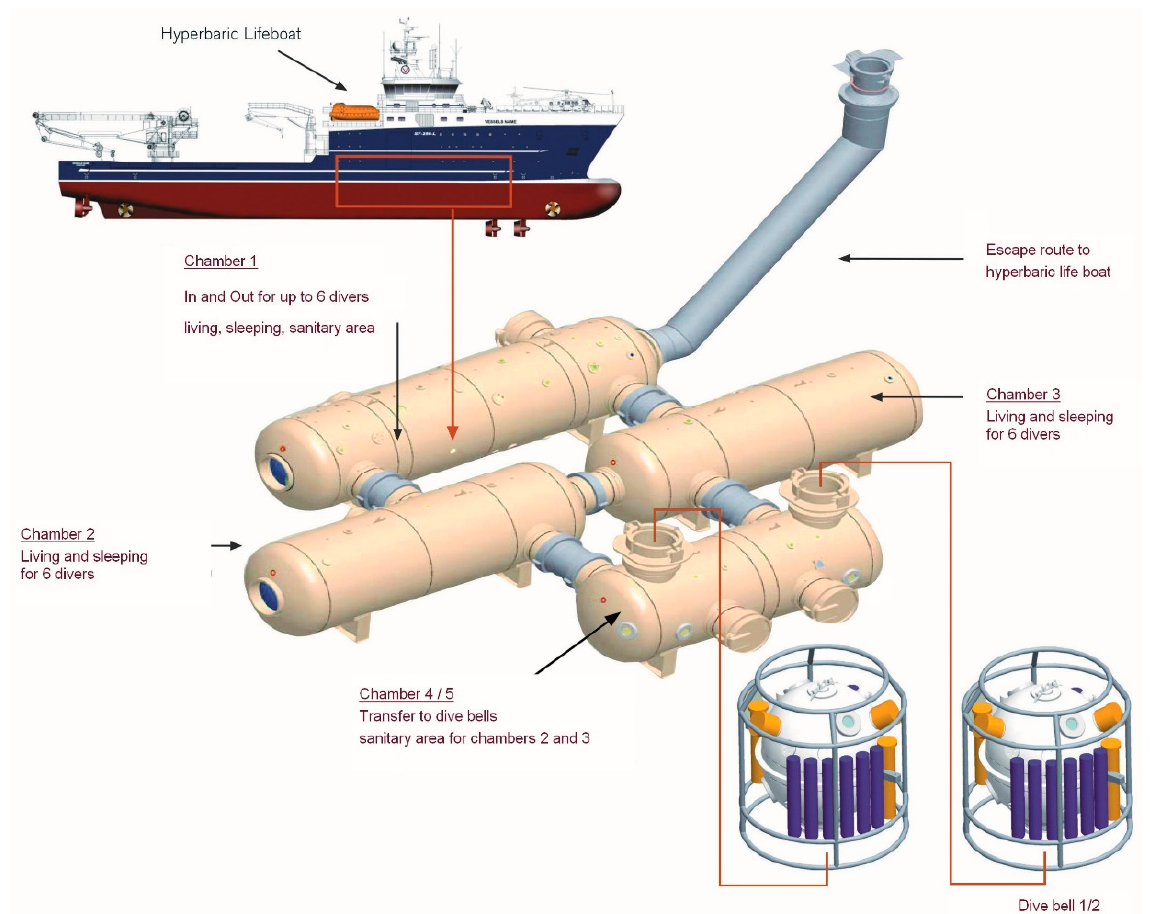
Figure 1. The divers’ support vessel ‘Bibby Topaz’ accommodates in its hull four hyperbaric chambers which are connected to each other. A diving bell can be connected to two of these chambers. Divers can be transported within these bells in the vicinity of the workplace. Reprinted with permission from [1]. Copyright 2006 Dräger Safety AG & Co. KgaA.